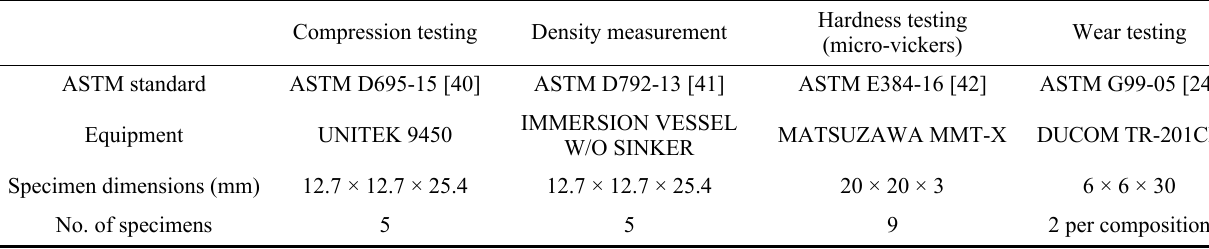
Table 4 Details of experimental setup and